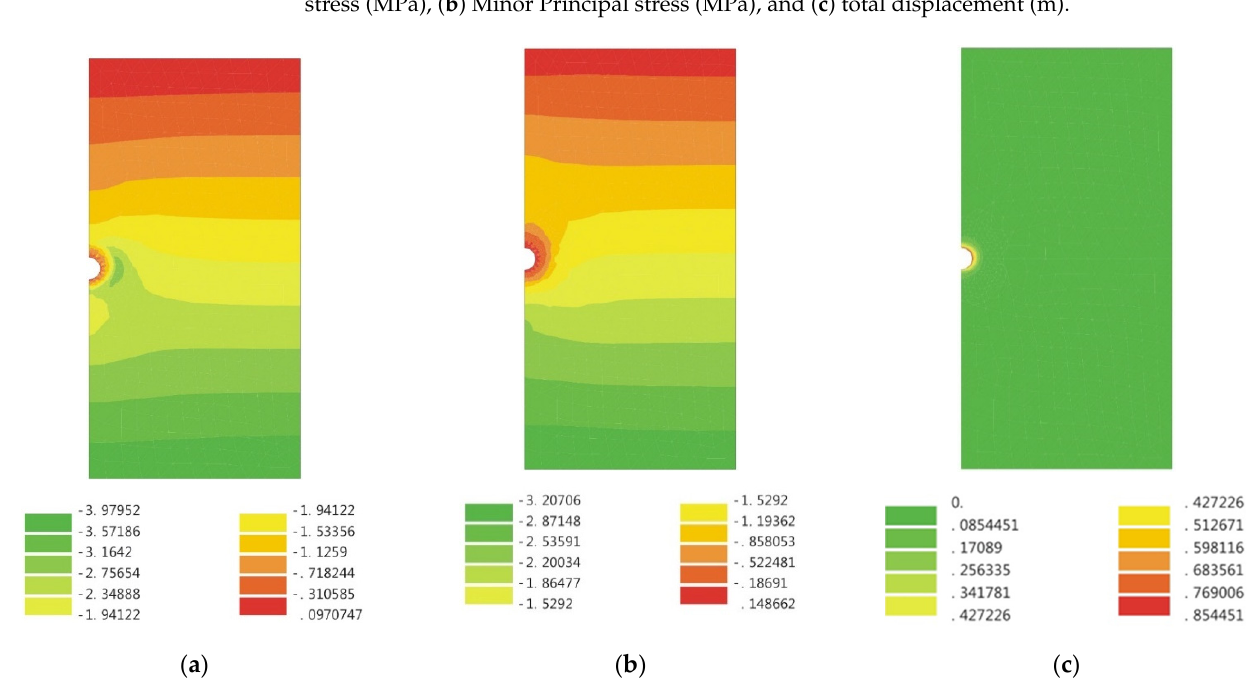
Figure 9. Iso-value contour plots of the final stress/displacement distribution around the tunnel under the initial anisotropic stress condition ( K o = 0.8) in finite element analysis. ( a ) Major Principal stress (MPa), ( b ) Minor Principal stress (MPa), and ( c ) total displacement (m).